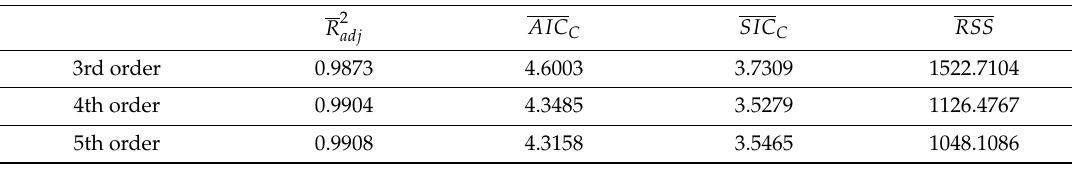
Table 1. The fitting performances for polynomial, sum of sine, and nonlinear mixed effects model (NLME) models. ( a ) The fitting performances of the polynomial with first-order autoregressive (AR(1)) model; ( b ) The fitting performances of the sum of sine with AR(1) model; ( c ) The number of times each model was chosen best over 15 profiles; ( d ) The fitting performances of NLME model based on two-sine